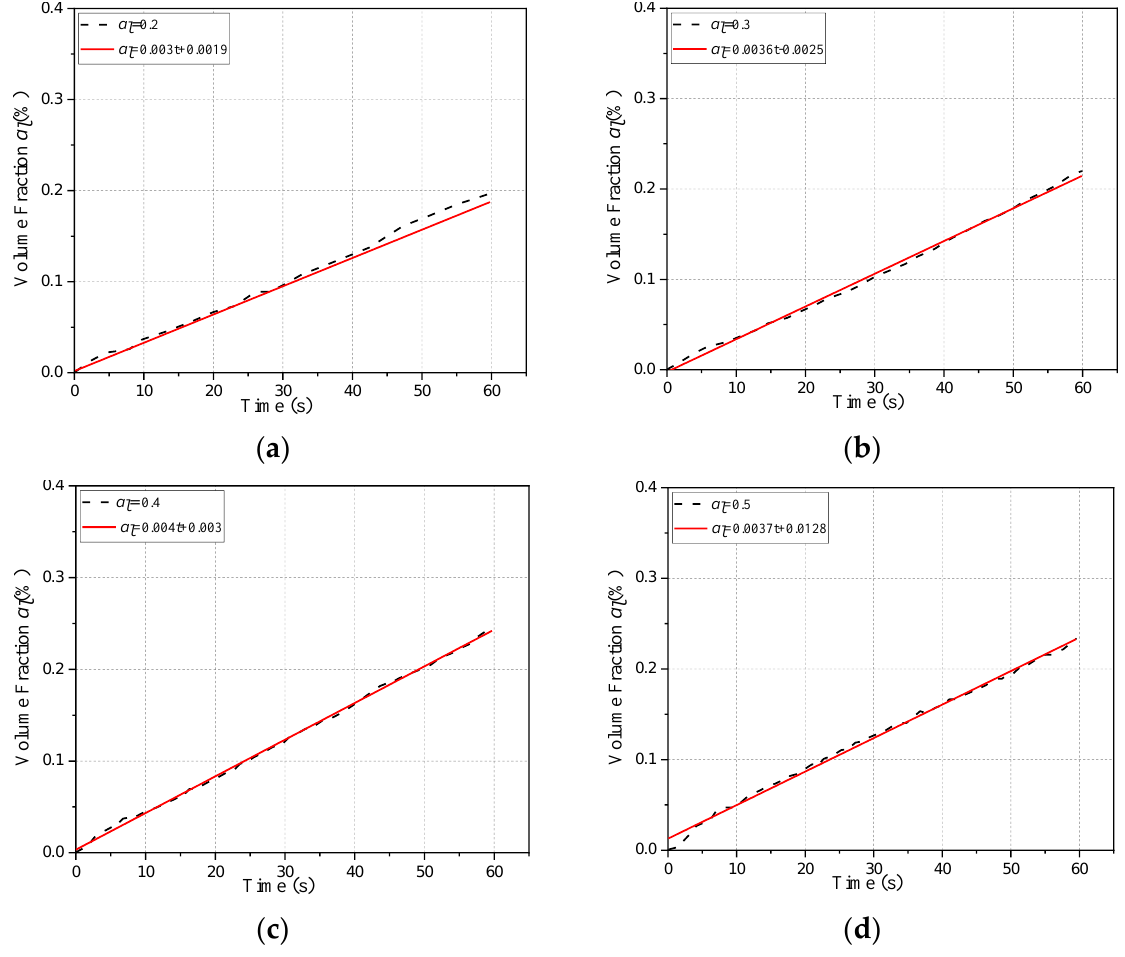
Figure 15. Curves of the liquid volume fraction with the time, together with the linear fitting results.